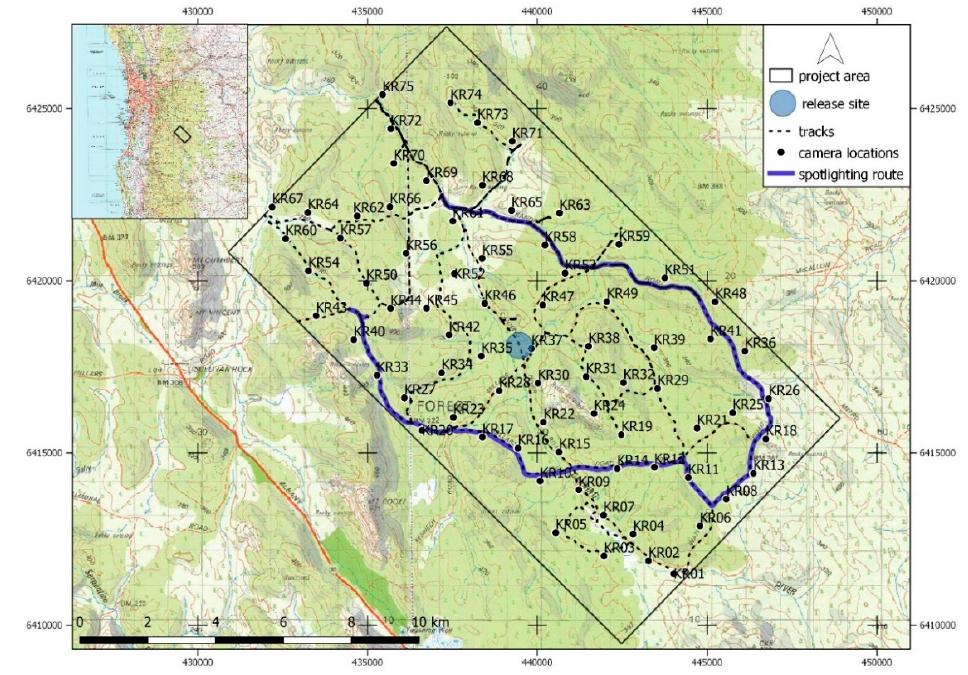
Figure 1. Relocation area showing point of release, camera trap array and driven spotlighting route.